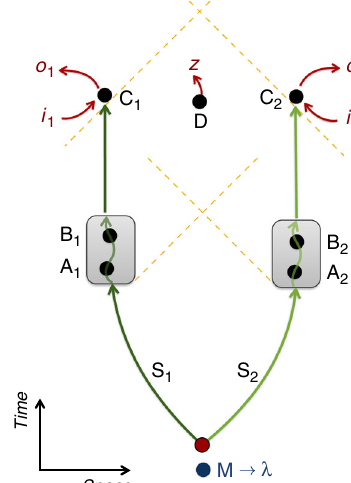
Fig. 2 Bell ’ s theorem for temporal order. A bipartite system, made of subsystems S 1 and S 2 , is sent to two groups of agents. Operations on S 1 (S 2 ) are performed at events A 1 , B 1 (A 2 , B 2 ). At event C 1 (C 2 ), a measurement with setting i 1 ( i 2 ) and outcome o 1 ( o 2 ) is performed. Events A 1 , B 1 are space-like separated from A 2 , B 2 and C 1 is space-like to C 2 ; light cones are marked by dashed yellow lines. The order of events A j , B j , j = 1, 2, is described by a variable λ de fi ned by a system M. The system M is measured at event D, producing an output bit z . If the initial state of the systems S 1 , S 2 , M is separable, and λ is a classical variable (possibly dynamical and probabilistic), the resulting bipartite statistics of the outcomes o 1 , o 2 cannot violate any Bell inequality, even if conditioned on z